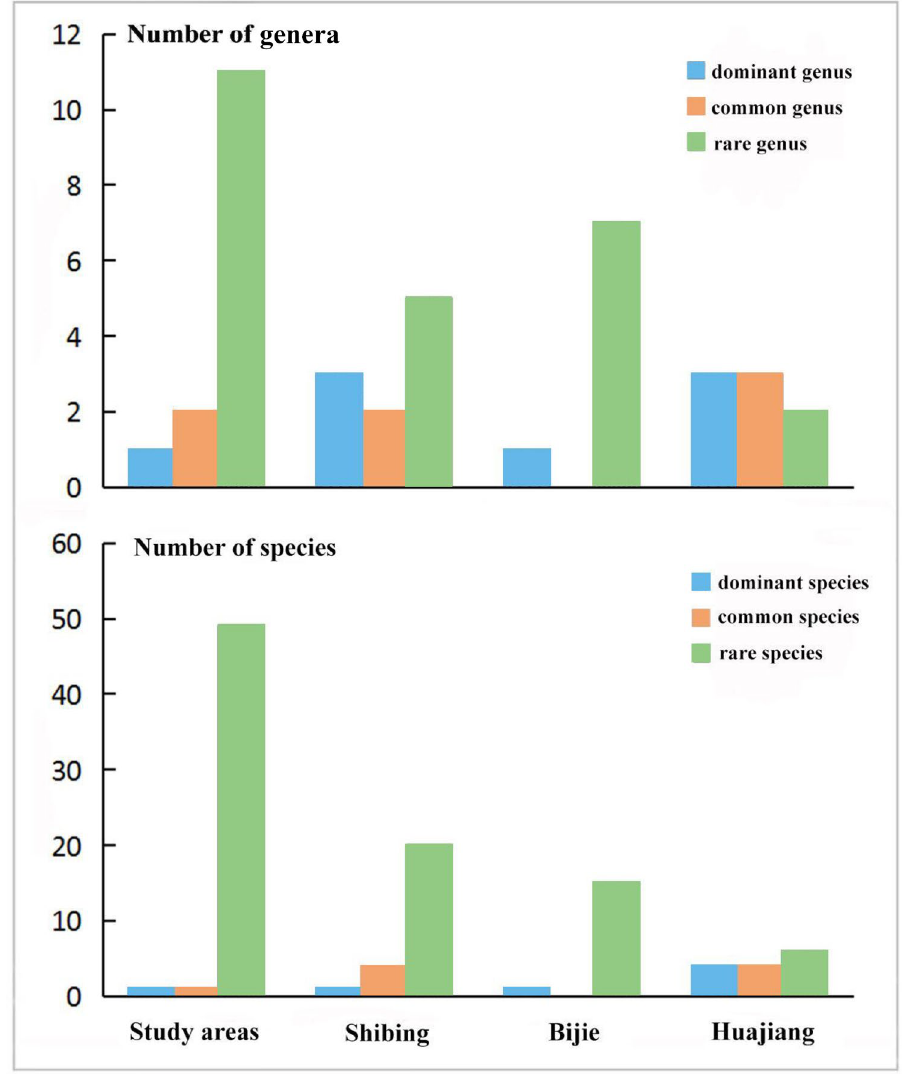
Figure 4. Abundance of genera and species of Erythroneurine leafhoppers in different study areas. Table 1. Community structure of Erythroneurine leafhoppers in the study areas.